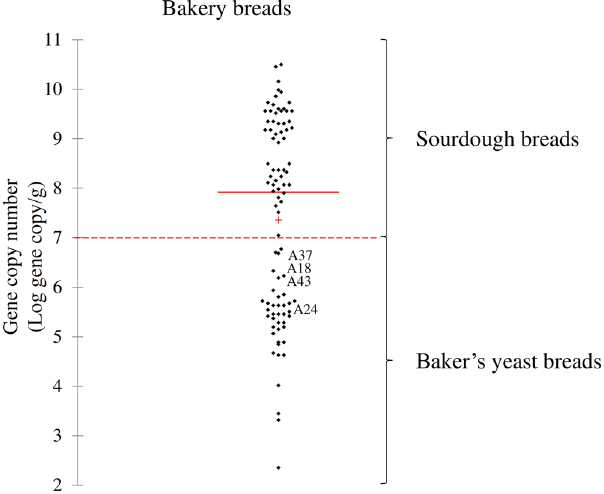
Figure 2. Scatterplot based on gene copy number obtained from bakery breads. Scatterplot based on gene copy numbers of sourdough or baker’s yeast breads collected from various bakeries. Mean ( + ), median (red line), and cut-off (dashed line) values are shown. Breads coded as A18, A24, A37, and A43 were claimed as sourdough breads. Information on the commercial breads collected from bakeries is reported in Supplementary Table